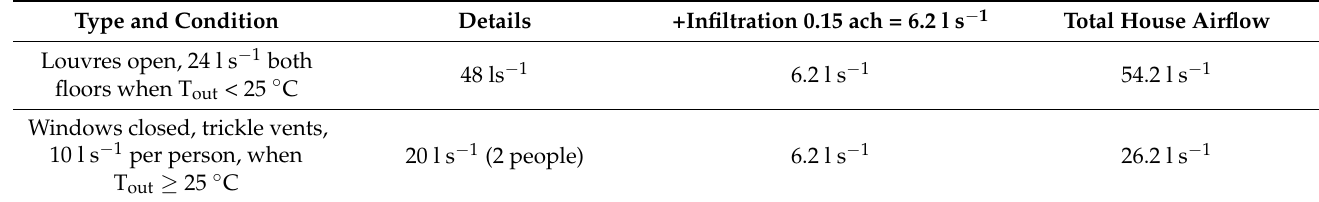
Table 7. Summary of infiltration and